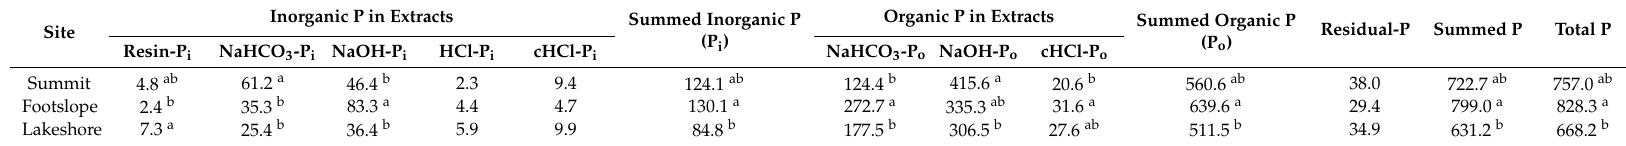
Table 2. The fractionation of P (mg kg − 1 ) in humic soil samples (O horizon) in different topographic sites (sequential